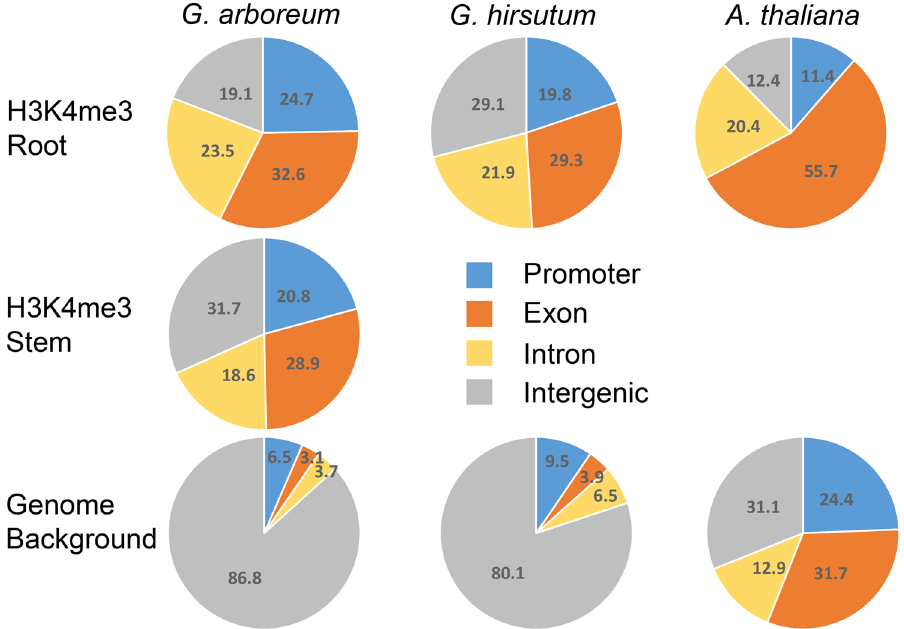
Figure 4. Genome background and H3K4me3 distribution ratio. The distribution of H3K4me3 histone modification and genome background within 4 main gene regions of known genes in root and stem tissues of three plant genomes ( G. arboreum , G. hirsutum and Arabidopsis thaliana